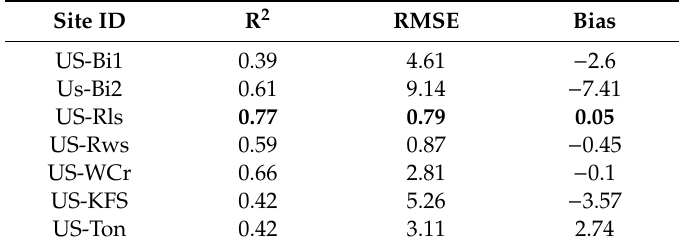
Table 4. Coe ffi cient of determination (R 2 ), root mean square error (RMSE, g C m − 2 d − 1 ), and